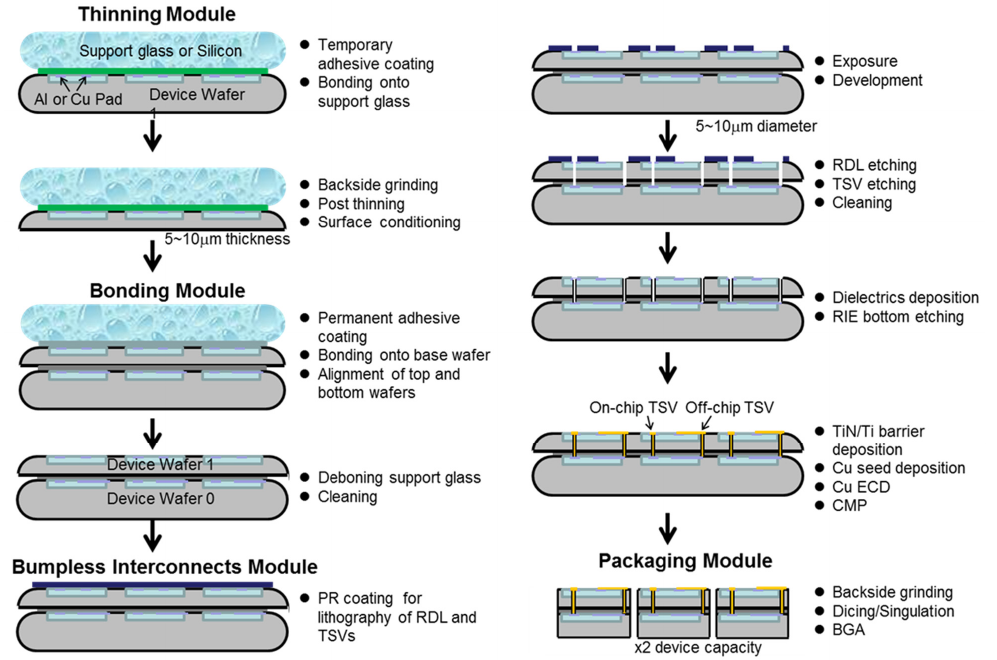
Figure 6. Process flow of bumpless interconnects using TSVs and Wafer-on-Wafer (WOW). Additional wafers can be stacked on top without any limitation on the number of wafers. These modules can also be applied to Chip-on-Wafer (COW) after wafer-level molding. On-chip and off-chip TSV, respectively represent bumpless interconnects formed in the device area and the area around devices, including gap fill (molding) materials in COW.